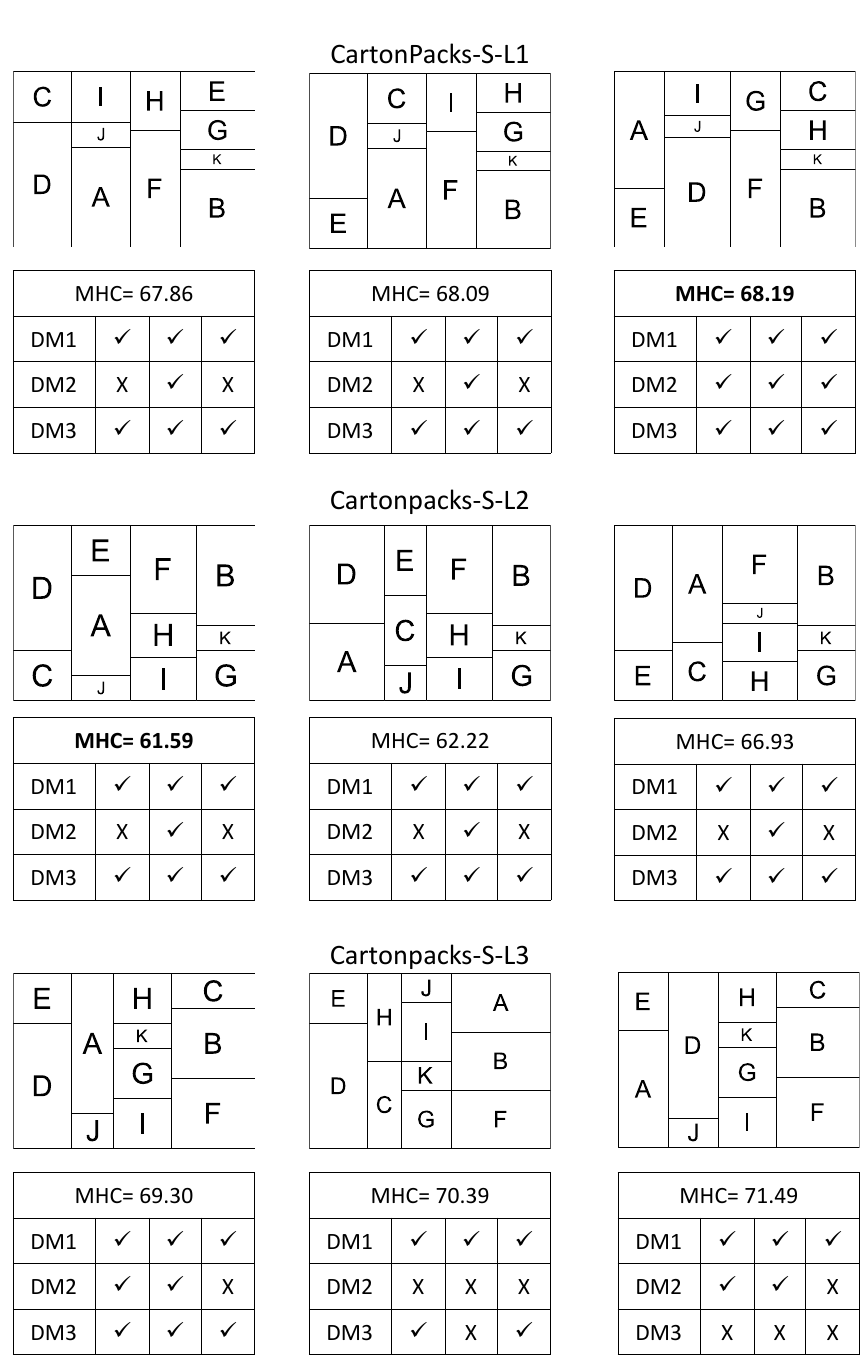
Figure 13. Best solutions found in Sequential launch 1 to 3 of CartonPacks